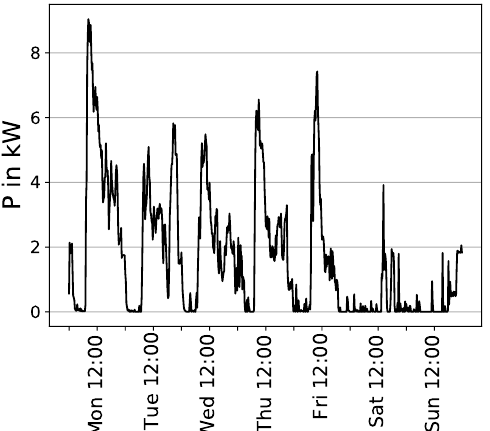
Figure 3. Weekly charging profile for the office site.